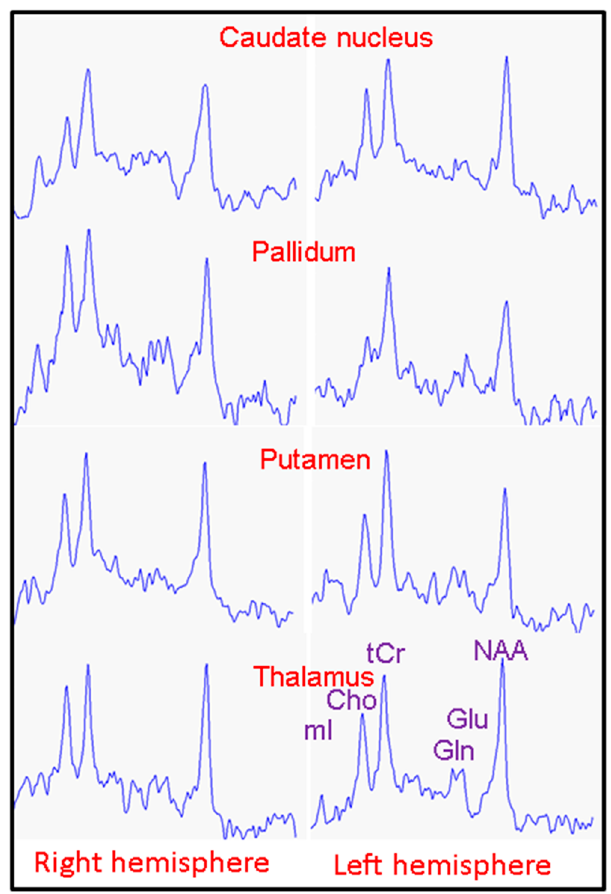
Figure 2. Example MR spectra obtained following averaging of multiple wbMRSI voxels over right and left caudate nucleus, putamen, pallidum, and thalamus from a 31-year-old male subject, from which the concentrations of the metabolites NAA, Cho, tCr, Glu, Gln, and mI of the brain structures were determined in spectral analysis.